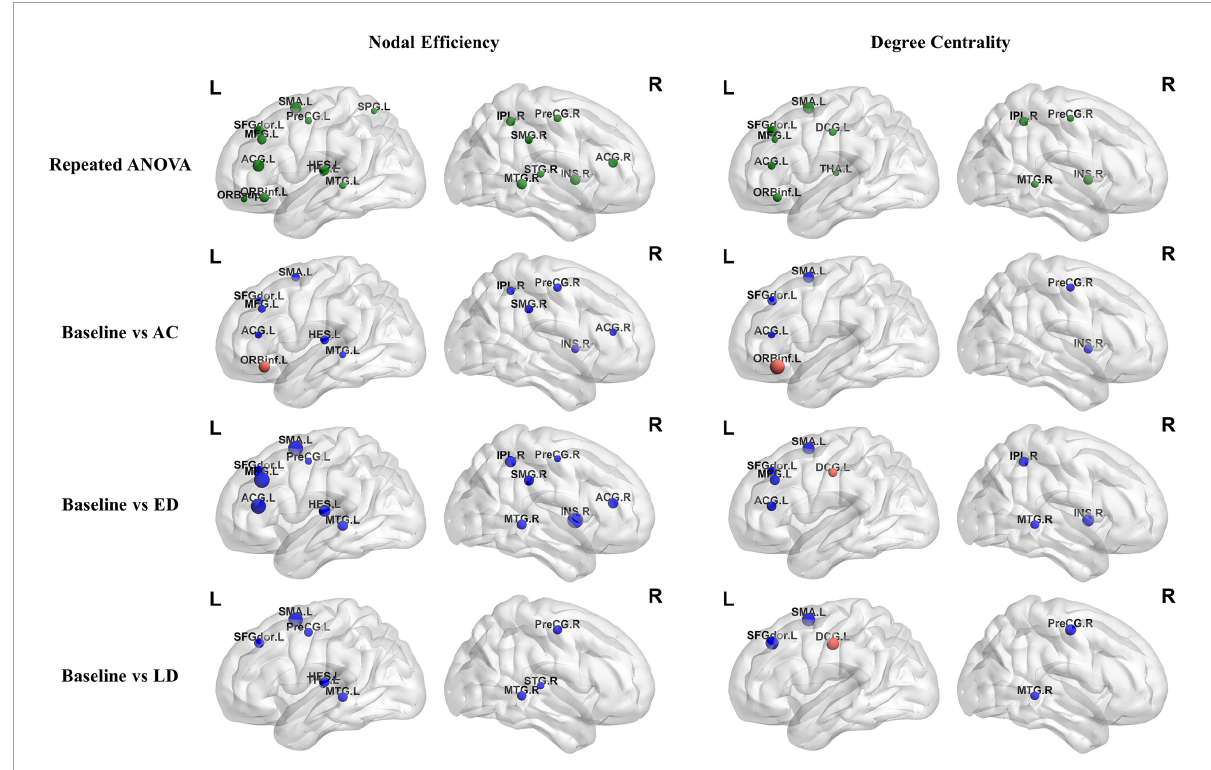
FIGURE2 The within-module and between-module connectivity strengths analysis of the four modules used. L, left hemisphere; R, right hemisphere; AC, post-RT-AC; ED, post-RT-ED; LD, post-RT-LD; ** p <